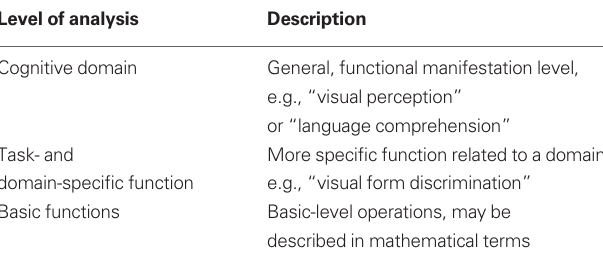
Table 1 | Levels of analysis in the relation between cognitive and neural events. The number of levels and their labeling are tentative yet serve to show the